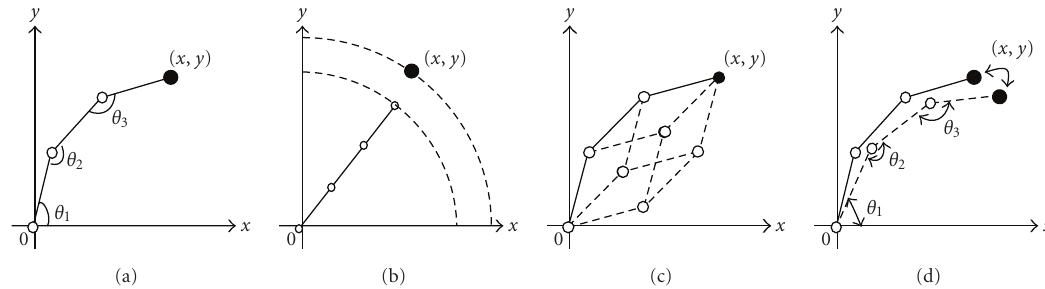
Figure 2: Inverse kinematics problem of 3-DOF robot arm in 2D plane. (a) Three joints and an end-e ff ector coordinate. Ill-posed solutions in terms of (b) existence, (c) uniqueness, and (d)